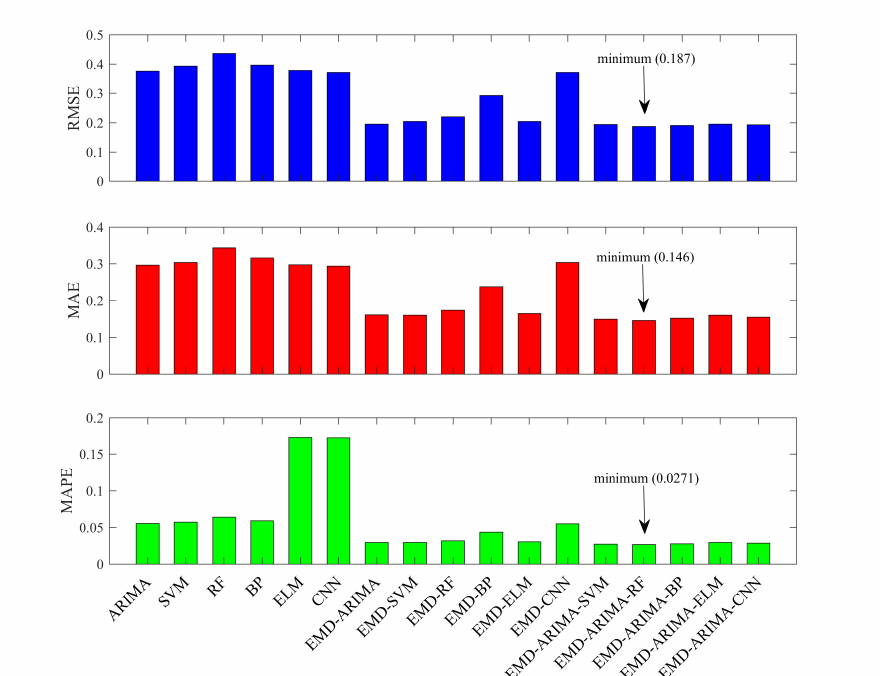
Figure 6. Wind speed prediction comparisons for the 10 min data at the AH site. Root mean square error (RMSE), mean absolute error (MAE) and mean absolute percentage error (MAPE).